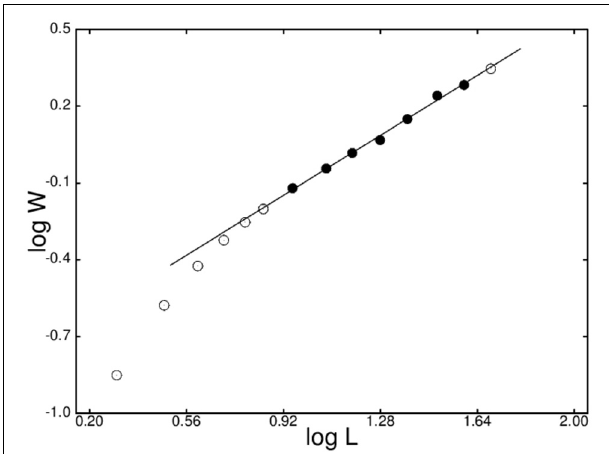
FIGURE 6 | Logarithmic plot, showing the roughness, W , as a function of the system size, L , for disorder D = − 4. Black circles denote those points to which the straight line, with slope ζ = 0 . 65(2), has been fitted. The largest errors for the black circles are comparable to the size of the